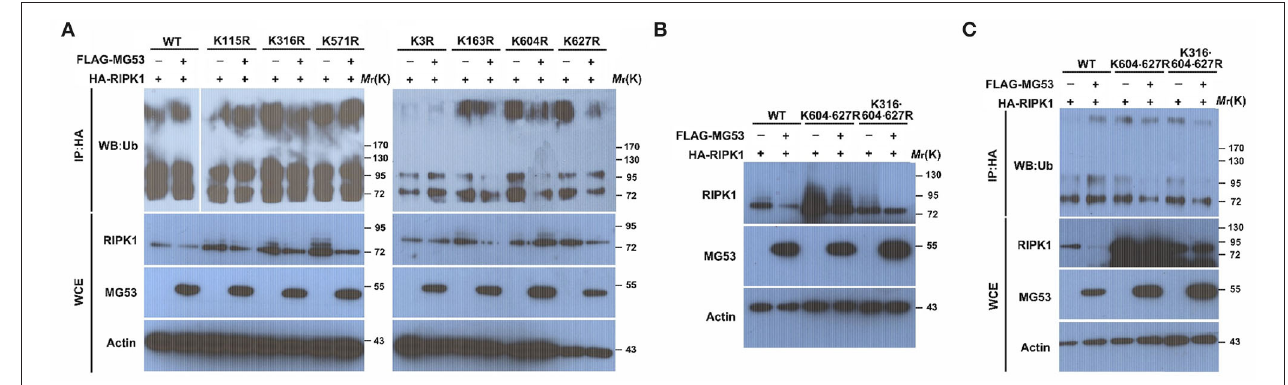
FIGURE 4 | The Lys316, Lys604, and Lys627 residues in RIPK1 are crucial for MG53-mediated ubiquitination. (A) wt as well as 7 individual RIPK1 mutant constructs with lysine to arginine mutation were co-transfected with FLAG-MG53 plasmid in HEK293 cells. Ubiquitination of RIPK1 was determined by western blot and compared with or without MG53. (B) double (K604-627R) and triple (K316-604-627R) mutation of RIPK1 were co-transfected with or without FLAG-MG53. Levels of RIPK1 were determined by western blot. (C) Ubiquitination of wt and mutant RIPK1 was detected with or without